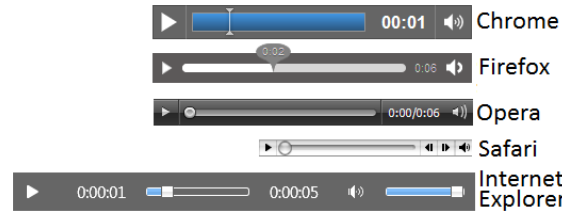
Fig. 1. Visualization of tag <audio> control elements by web-browsers.